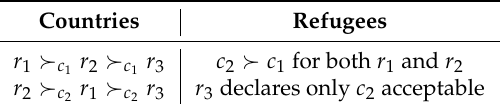
Table 1. Table specifying refugees’ and countries’ preferences for Example 1. a (cid:31) c b denotes that c strictly prefers a to b